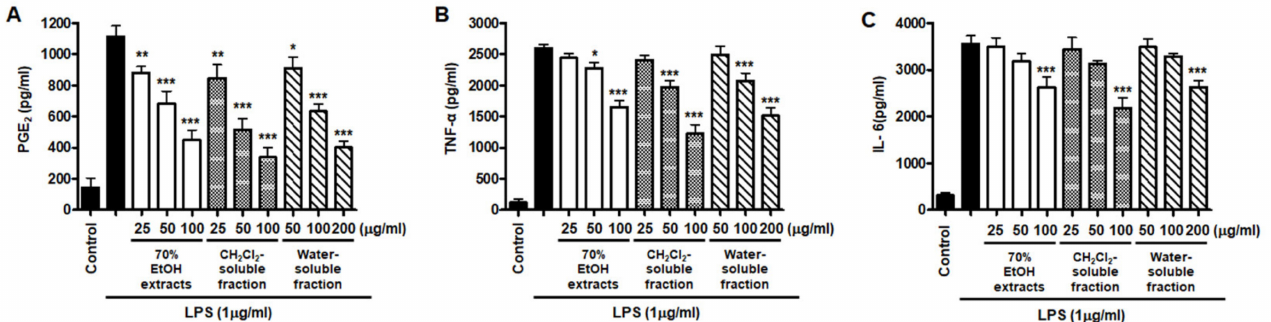
Figure 7. Effects of 70% EtOH extract and its CH 2 Cl 2 - and water-soluble fractions on the levels of PGE 2 ( A ), TNF- α ( B ), and IL-6 ( C ) in BV2 cells. Cells were pretreated for 3 h with the indicated concentrations of S. horneri extract and its fractions, and stimulated for 24 h with LPS (1 µ g/mL). The methods used to measure the PGE 2 , TNF- α , and IL-6 levels are described in detail in the Materials and Methods section. Bars represent the mean ± standard deviation of 3 independent